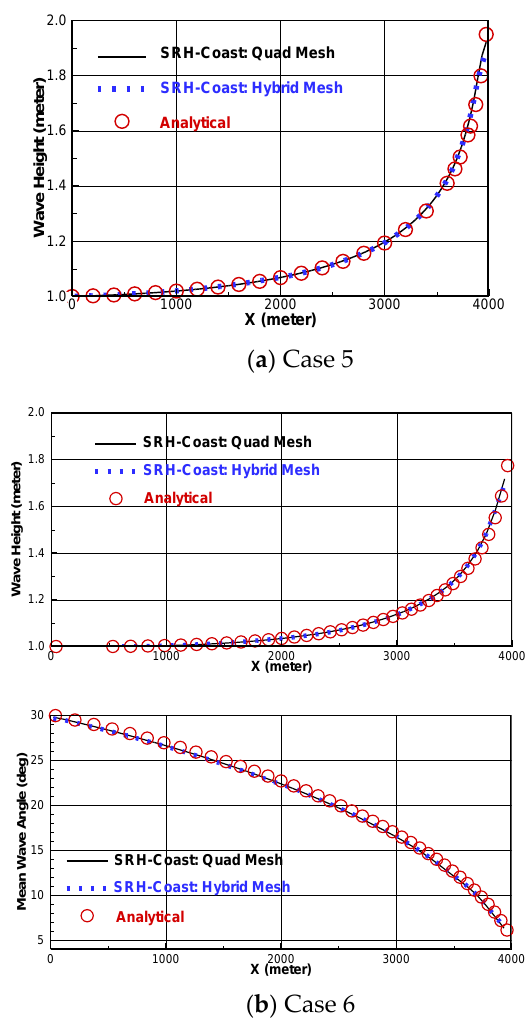
Figure 8. The significant wave height and mean wave propagation angle and comparison with analytical solutions.